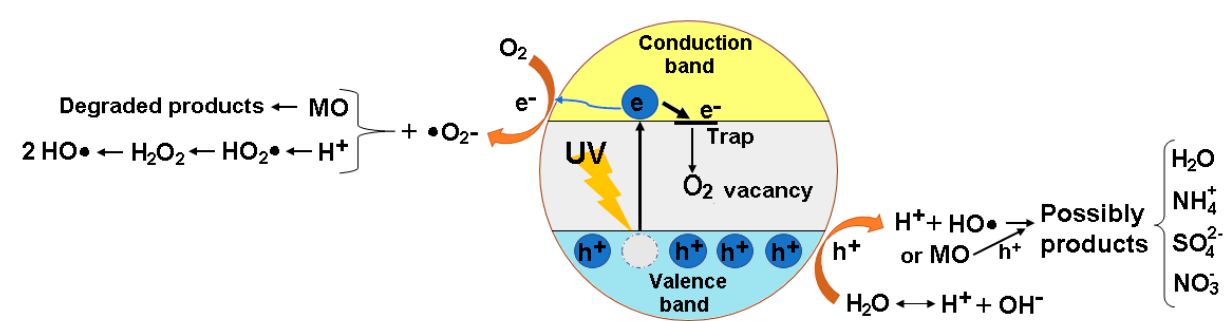
Figure 8. Proposed photodegradation mechanism of Fe 3 O 4 /PVA composite for the degradation of Methyl Orange (MO)